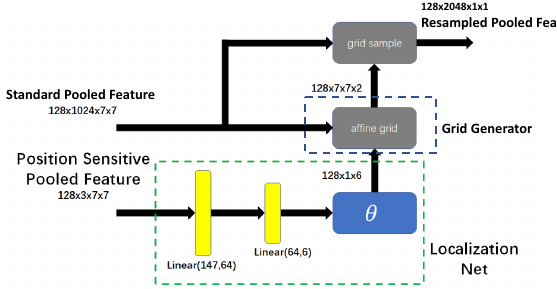
Figure 4. The specific architecture of the resampled pooled feature subnetwork in Fig. 2, which consists of Localization Network, Grid Generator, and